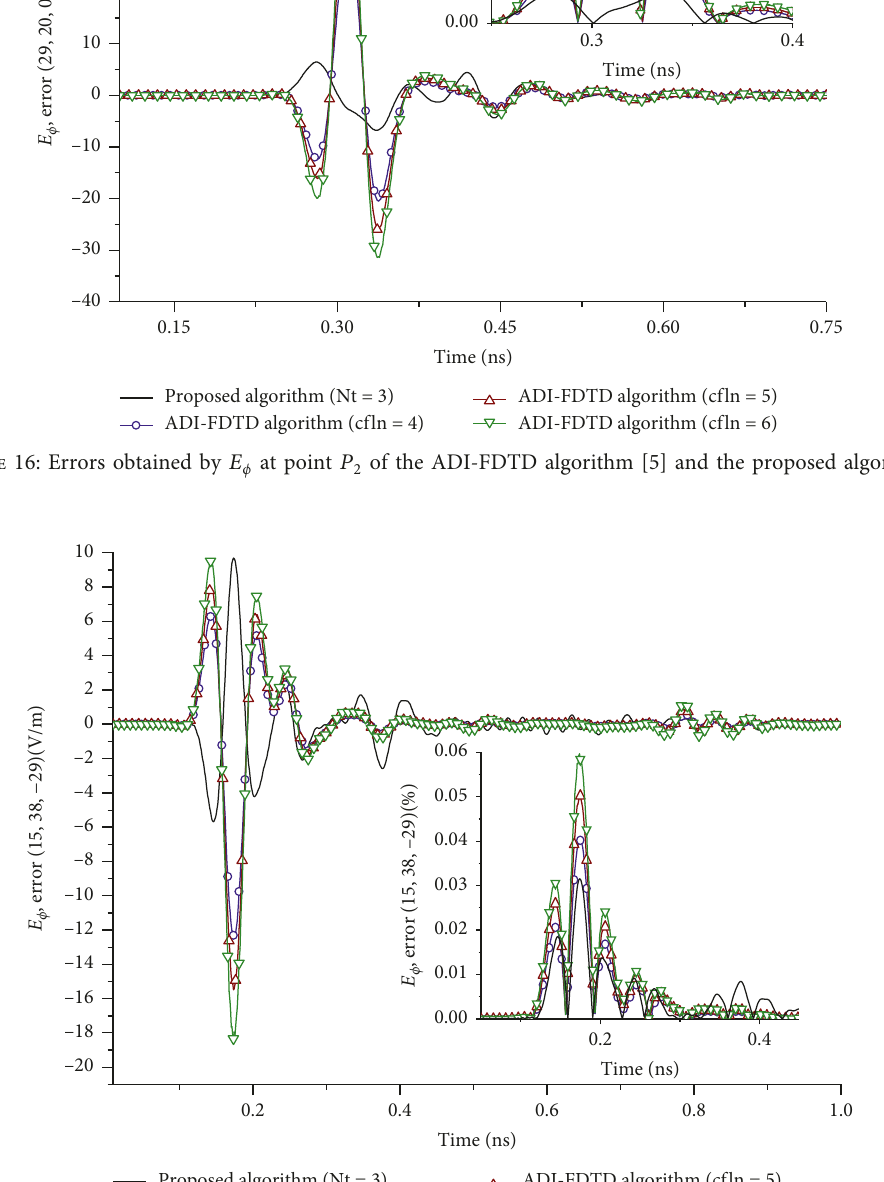
P ϕ at point 3 of the ADI-FDTD algorithm [5] and the proposed